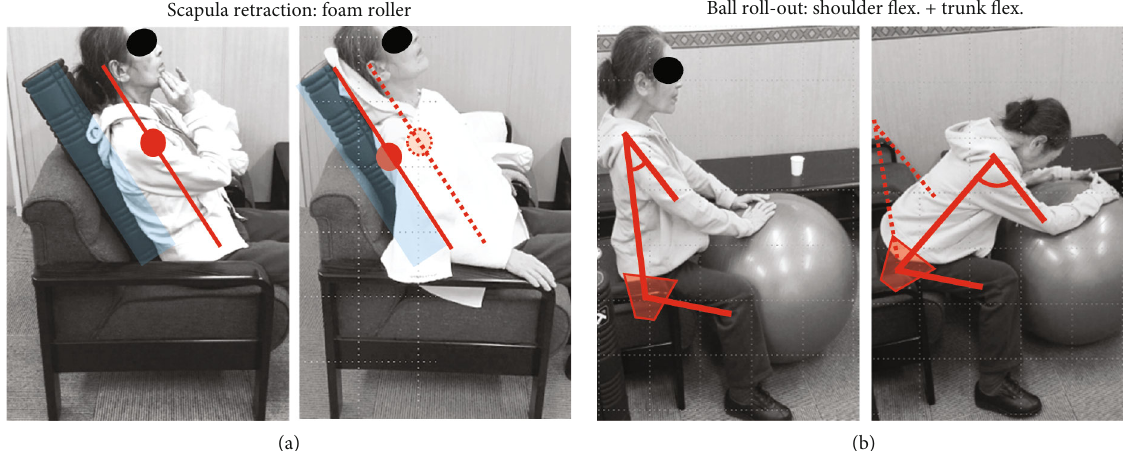
Figure 5: Representative exercises of our AR-PT (phase II) for the present patient. (a) Scapular retraction with a foam roller. As the patient was able to lean back on the sofa only with head support, scapular retraction was introduced for her to become aware of her habitual control of posture. This exercise corresponded to the phase II ➀➁➂ programs. (b) Ball roll-out exercise for shoulder fl exion and trunk fl exion. Kinesthetic awareness of craniospinal balance needed to be learned initially, and proprioception and coordination training of her posture were taught such as shoulder fl exion, trunk fl exion, and anterior pelvic tilt. This exercise corresponded to the phase II ➀➁➂ programs.